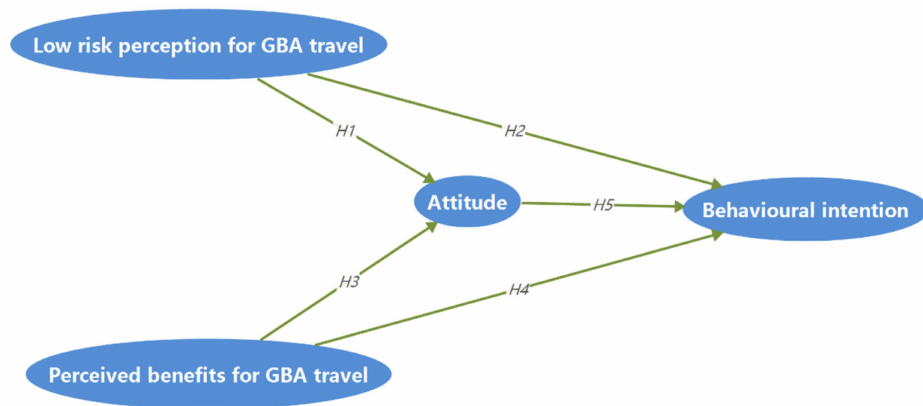
Figure 1. Research